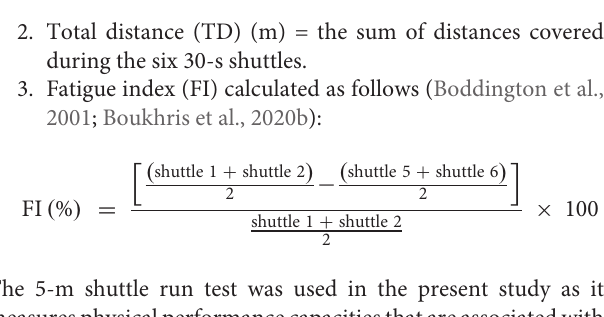
room for these activities) (NN condition), to nap for 25 min (N25), or to nap for 45 min (N45). Daytime napping